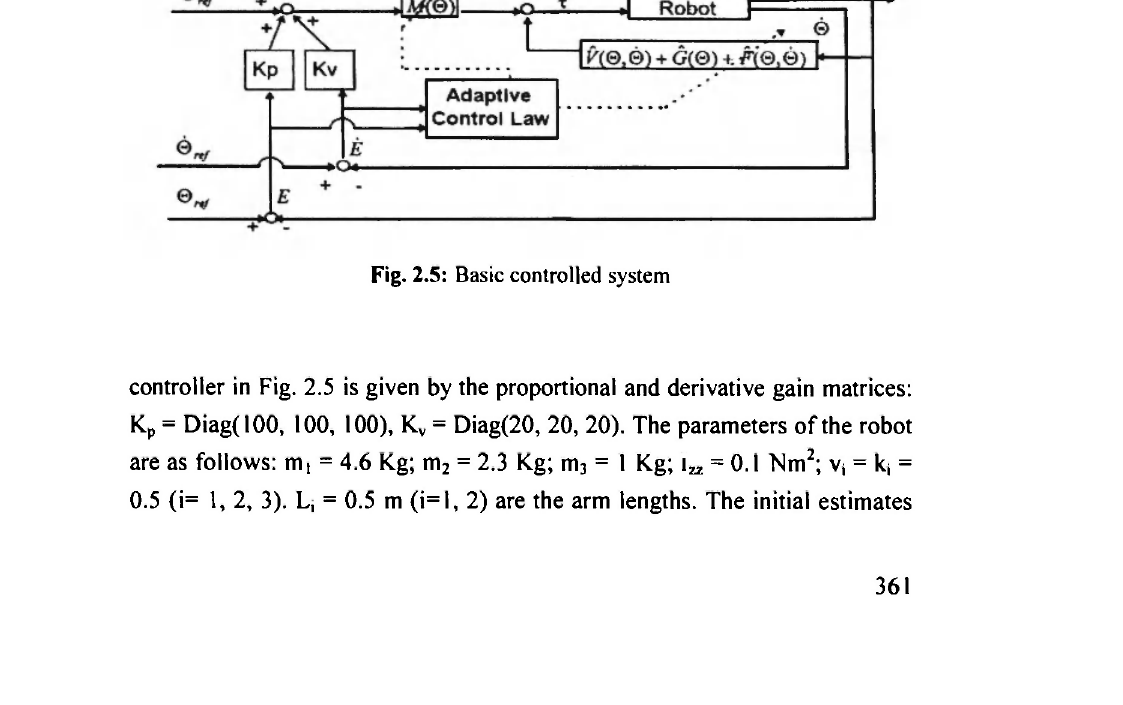
Fig. 2.4: Simulation of manipulator control using GRASP